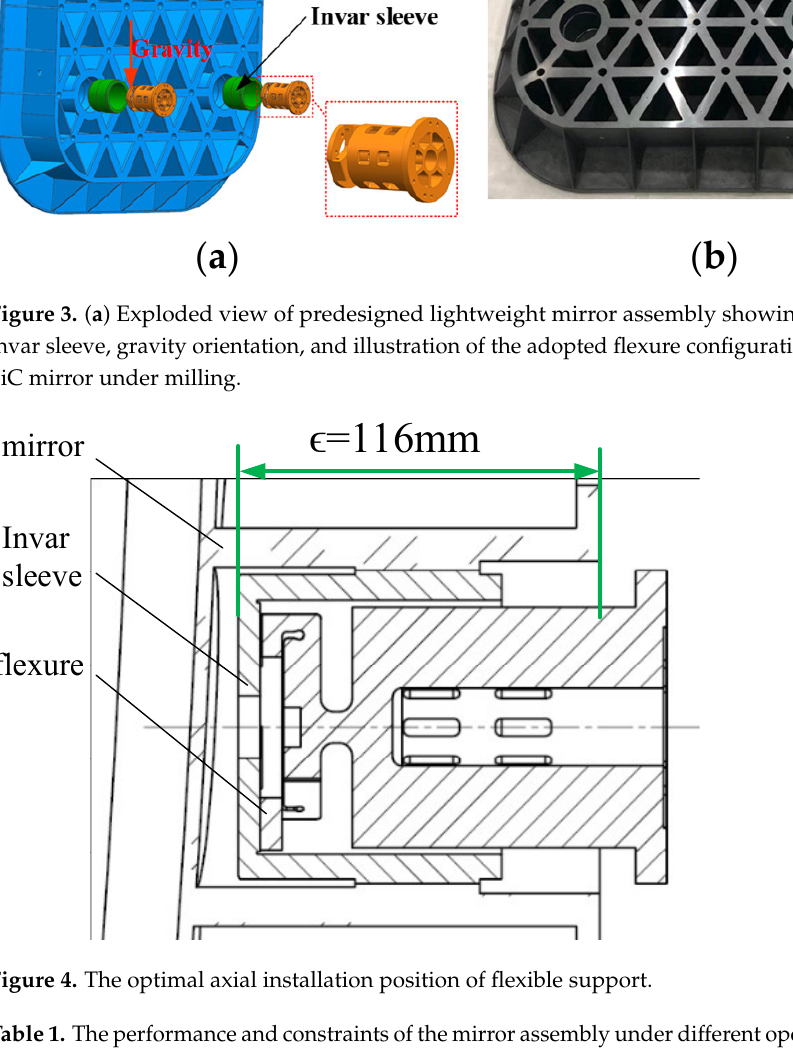
Figure 3. ( a ) Exploded view of predesigned lightweight mirror assembly showing the symmetries, invar sleeve, gravity orientation, and illustration of the adopted flexure configuration. ( b ) The square SiC mirror under milling. Table 1. The performance and constraints of the mirror assembly under different operating condi- tions.